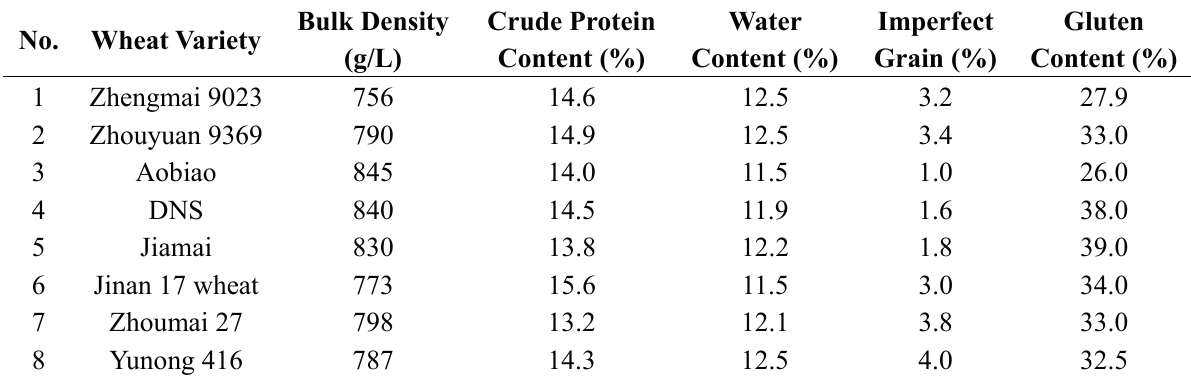
Table 1. The Properties of the eight wheat varieties under